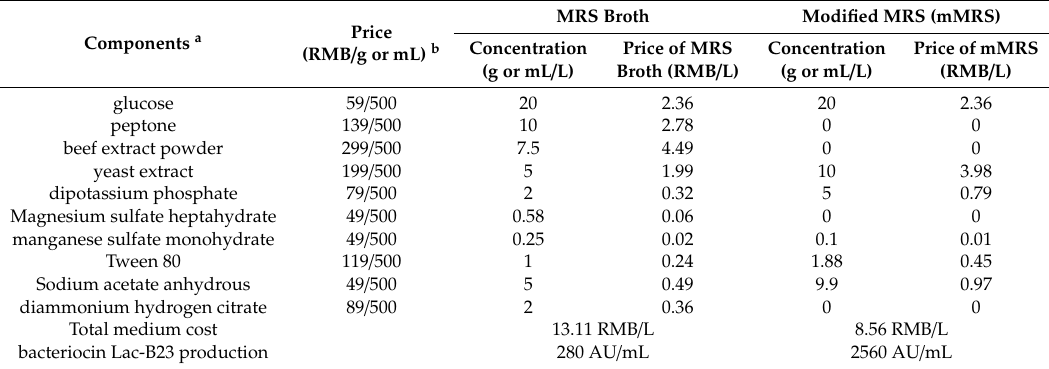
Table 9. Components, bacteriocin Lac-B23 production and cost analysis for the De Man, Rogosa and Sharpe (MRS) broth and modified MRS